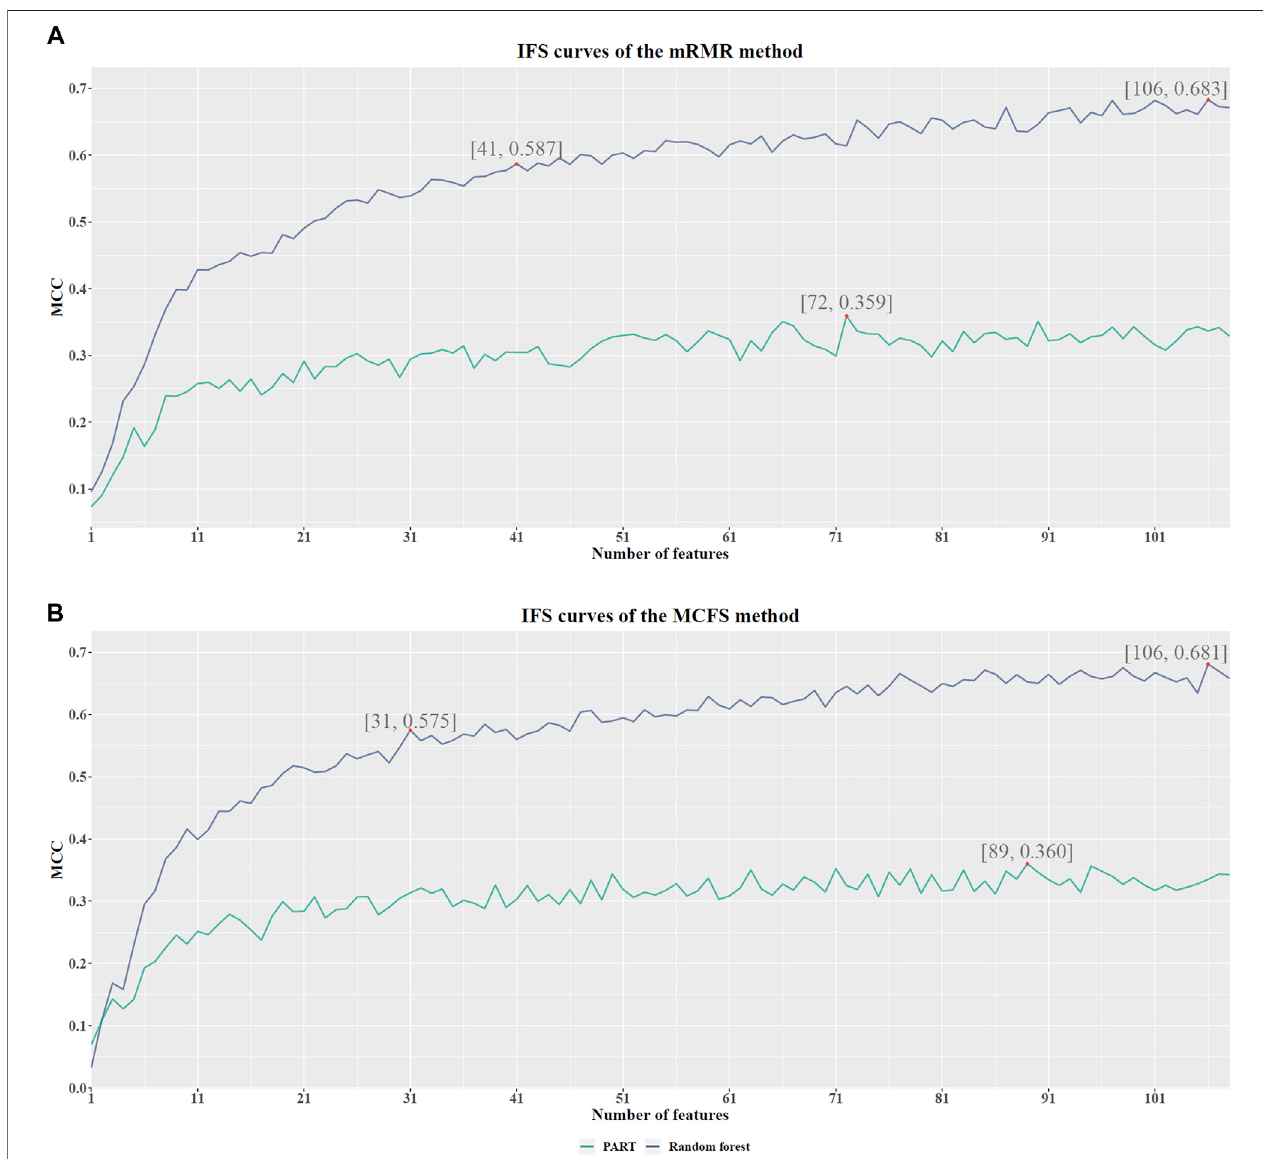
FIGURE 3| IFS curves with different number of features in RF and PART under the mRMR and MCFS featurelists. (A) . With the mRMR feature list, RF reaches the highest point (MCC = 0.683) with the top 106 features, and PART obtains the highest MCC (0.359) when using the top 72 features. The RF with top 41 features also provides high performance (MCC = 0.587). (B) . With the MCFS featurelist, RF and PARTreach the highest points (MCC =0.681 and 0.360, respectively) at the top 106 and 89 features. The RF with top 31 features also yields high performance (MCC = 0.575).